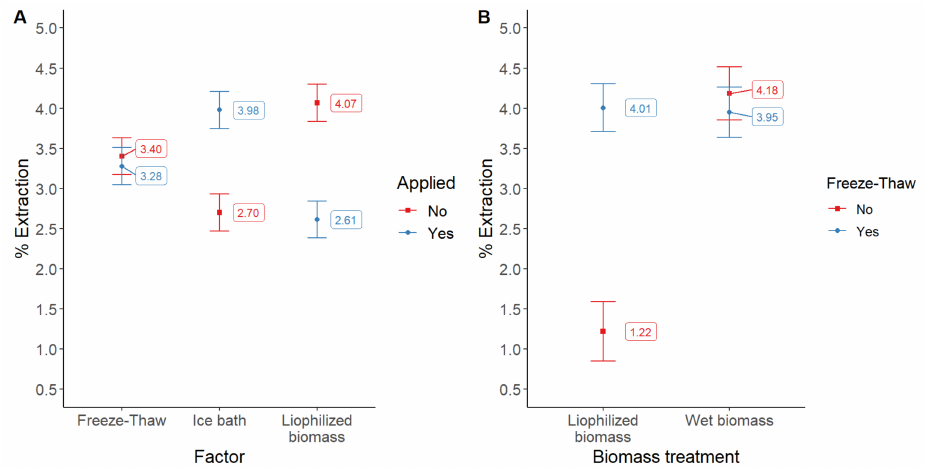
Figure 7. Comparative extraction yields of phycocyanin (%) as a function of three operational parameters ( A ), and ( B ) as a function of the interaction of biomass treatment vs. freeze–thaw procedure application. Bars show the least significant difference intervals for 95% confidence.